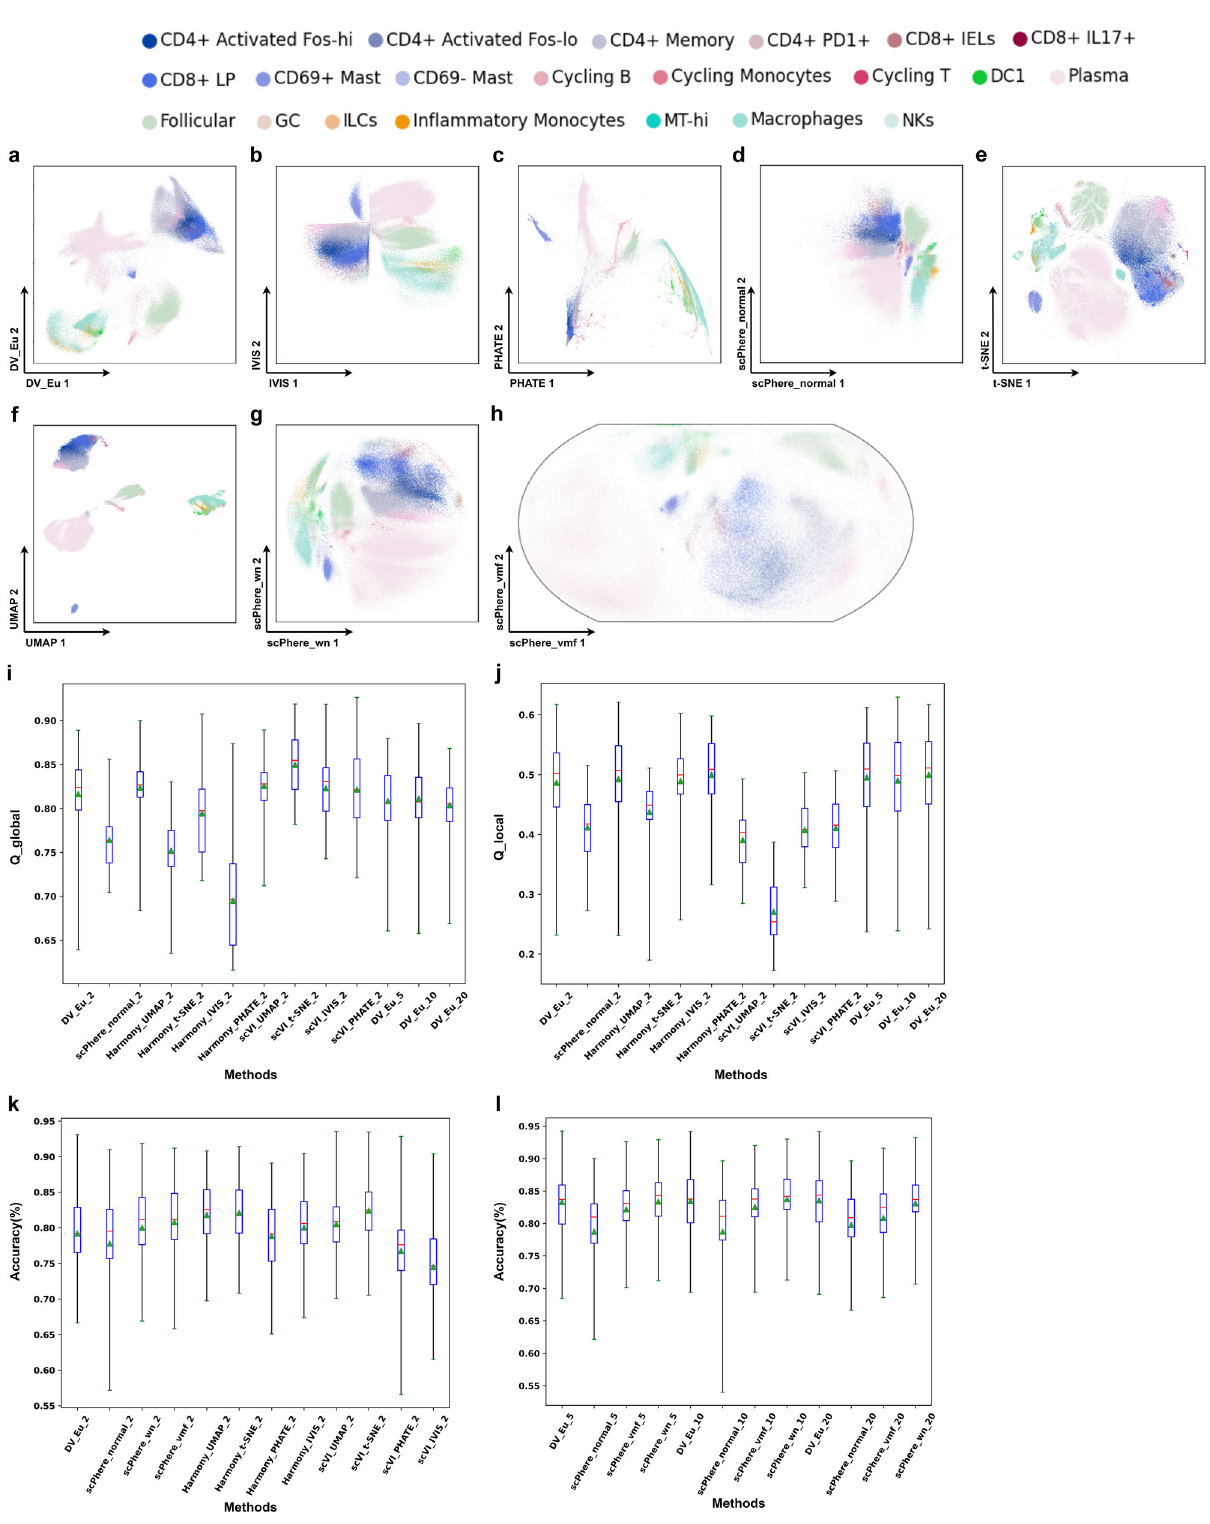
Fig. 4 DV addresses complex technical and biological batch for visualization and analysis in colon biopsies (SCP259) from healthy individuals and UC immune patients. 2-dimensional DV_Eu ( a ), scPhere_normal ( d ), scPhere_wn ( g ) and scPhere_vmf ( h ) embeddings accounting for the patient, location, and disease status. 2-dimensional IVIS ( b ), PHATE ( c ), t-SNE ( e ) and UMAP ( f ) embeddings (batch-corrected by Harmony accounting for the patient status). Successful batch correction visualization as re fl ected by local ( i ) and global ( j ) geometric structure preservation performance (y-axis), and k -NN classi fi cation accuracy (y axis, k = 5) in 2-dimensional ( k ) and low-dimensional( l ) embeddings. The geometric structure preservation is tested on the cells from one patient between input of model and visualization embeddings. The k -NN classi fi cation accuracy is tested on the cells from one patient after training on the cells from all other patients. Boxplots denote means, medians and interquartile ranges (IQRs). The whiskers of a boxplot are the lowest datum still within 15 IQR of the lower quartile and the highest datum still within 15 IQR of the upper quartile. COMMUNICATIONS BIOLOGY| (2023) 6:369